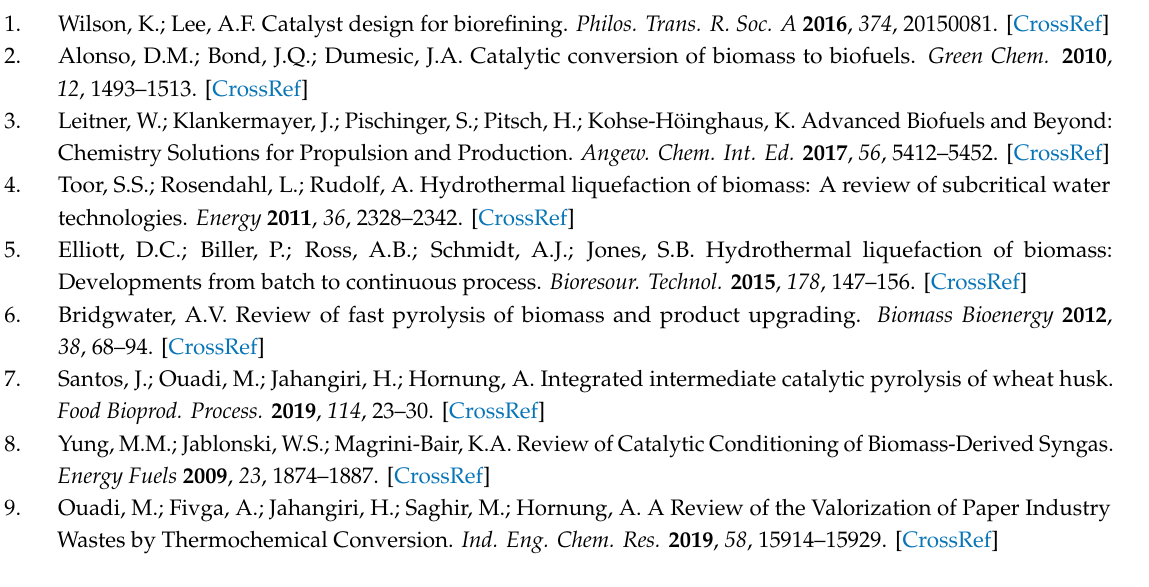
Supplementary Materials: The following are available online at http: // www.mdpi.com / 2073-4344 / 9 / 10 / 841 / s1, Figure S1: XRD patterns of xGa / HZSM-5 and bulk Ga 2 O 3, ; Figure S2: N 2 adsorption-desorption isotherms of xGa / HZSM-5 and Ga 2 O 3 ; Figure S3: (a) Al 2p and (b) Si 2p XP spectra of xGa / HZSM-5; Figure S4: (a) DRIFT spectra of pyridine-saturated xGa / HZSM-5 and Ga 2 O 3 and (b) corresponding Lewis:Brønsted acid site ratio (1444 cm − 1 : 1545 cm − 1 bands) for xGa / HZSM-5; Figure S5: Density of strong and weak acid sites for xGa / HZSM-5 from propylamine TPRS; Figure S6: Acetic acid conversion over xGa / HZSM-5, and Ga 2 O 3 vs time on stream. Reaction conditions: 200 mg catalyst, at 400 ◦ C, 0.2 mL · min − 1 acetic acid, 50 mL · min − 1 N 2 , 1 bar; Figure S7: XRD patterns of (a) fresh and (b) post-reaction xGa / HZSM-5 and Ga 2 O 3 ; Figure S8: Correlation between acetone selectivity from acetic acid ketonisation at iso-conversion (23% and 29% at 350 ◦ C and 400 ◦ C, respectively) and acid strength from propylamine temperature-programmed reaction spectroscopy (higher temperatures indicate weaker acidity) over xGa / HZSM-5, and Ga 2 O 3 ; Table S1: Surface and bulk composition of xGa / HZSM-5 and Ga 2 O 3 ; Table S2: Carbon content of used xGa / HZSM-5 and Ga 2 O 3 after 5 h